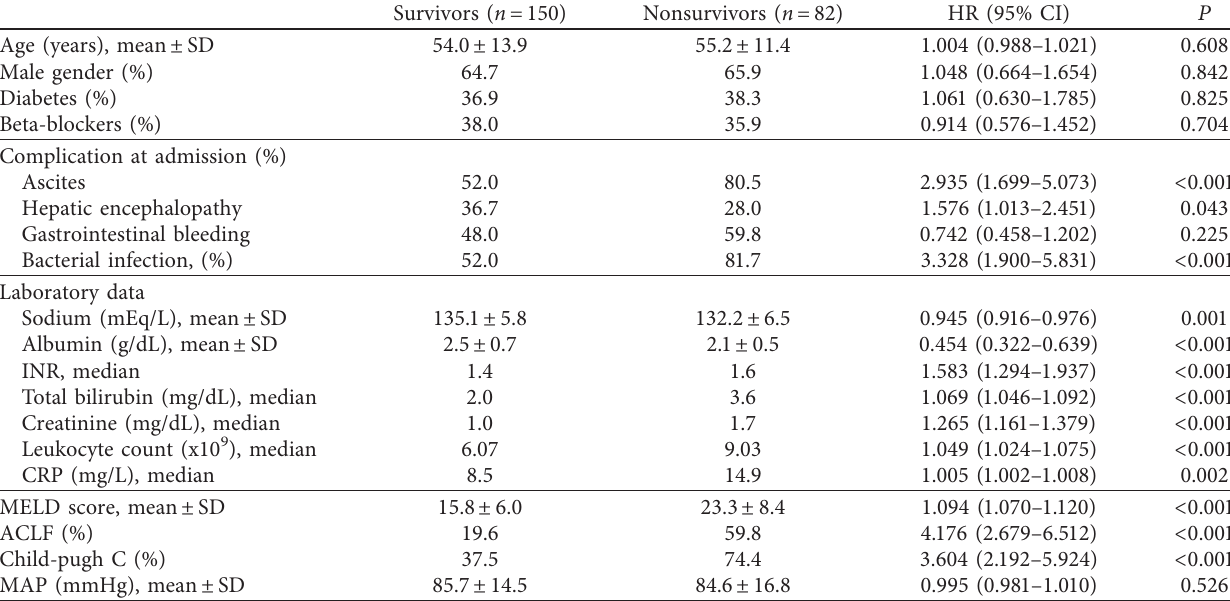
Table 4: Comparison of demographic, clinical, and laboratory data according to 90-day survival among patients with SIRS ( n �